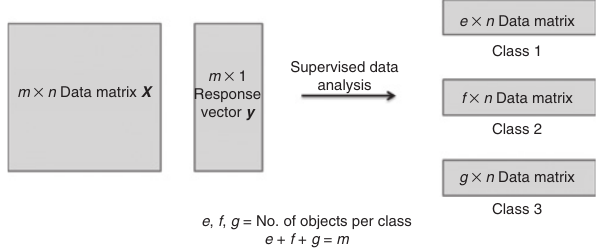
Figure 4: Visualization of the supervised data analysis principle for classification